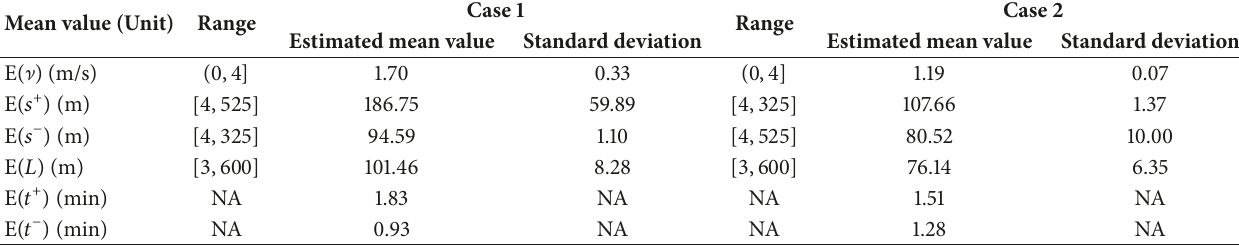
Table 3: Indicators’ mean